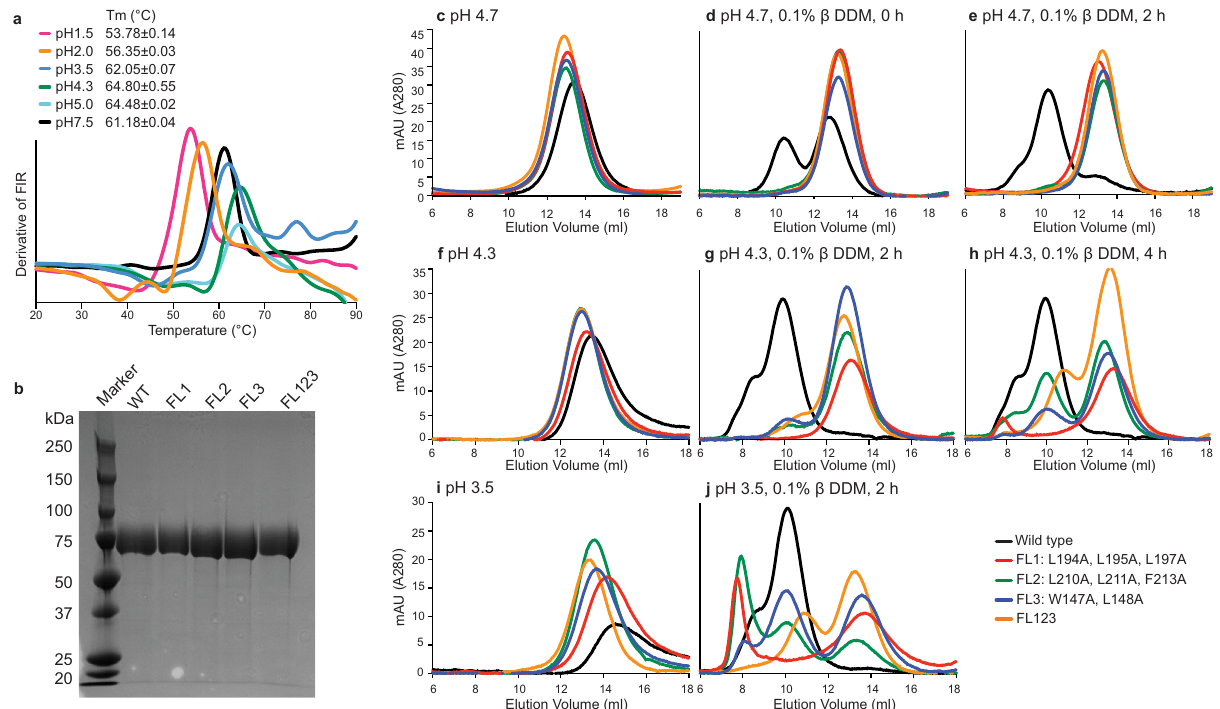
Fig. 8 Stability of Cyani HAP2 ectodomain to pH and requirement of fusion loop hydrophobic residues for detergent-dependent trimerization. a Temperature-dependent unfolding of HAP2 ectodomain measured by tryptophan fl uorescence intensity ratio (FIR) at indicated pH values. The fi rst derivative is plotted. Tm values are mean ± difference from the mean. b Puri fi ed proteins (3 μ g) were subjected to SDS 10% PAGE and Coomassie blue staining. SDS-PAGE of Cyani HAP2 wild type and mutant ectodomains protein was conducted three times with essentially identical results. c – j Size exclusion chromatography of Cyani HAP2 wild type and mutant ectodomains treated with or without 0.1% DDM in buffers at the indicated pH values for the indicated times at 37 °C and subjected to size exclusion chromatography in buffers of the indicated pH values in absence or presence of 0.01% DDM,